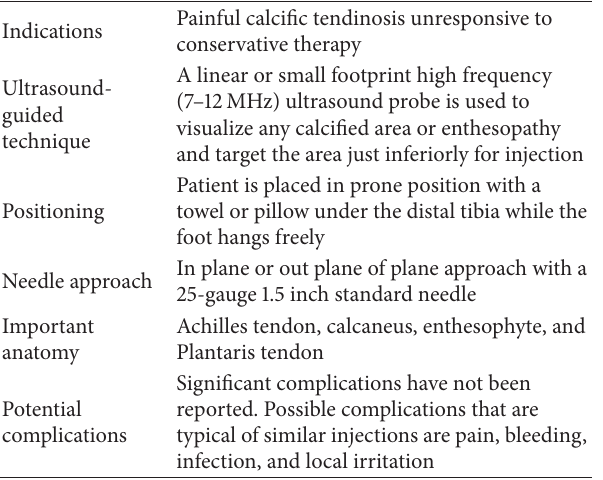
Table 1: Ultrasound-guided prolotherapy injection of insertional Achilles calcific tendinosis in the primary care